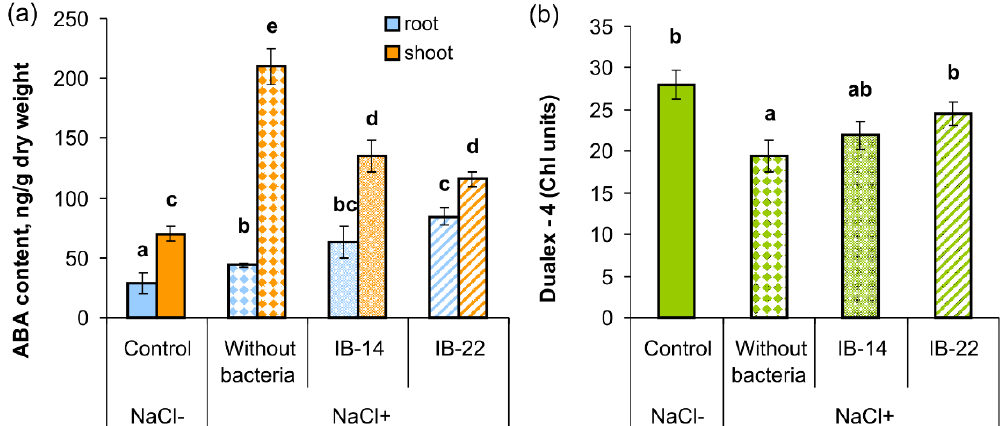
Figure 3. Effect of salt stress and seed bacterial inoculation on shoot and root ABA concentration ( n = 6), ( a ) and leaf chlorophyll (Chl a + Chl b) concentrations in wheat plants ( n = 25), ( b ) at the stage of tillering in the field experiments: IB-14 —P. mandelii IB–Ki14; IB-22— B. subtilis IB–22; control—option without bacterization and salinity. Significantly different means for each variable are labeled with different letters ( p ≤ 0.05; LSD test).